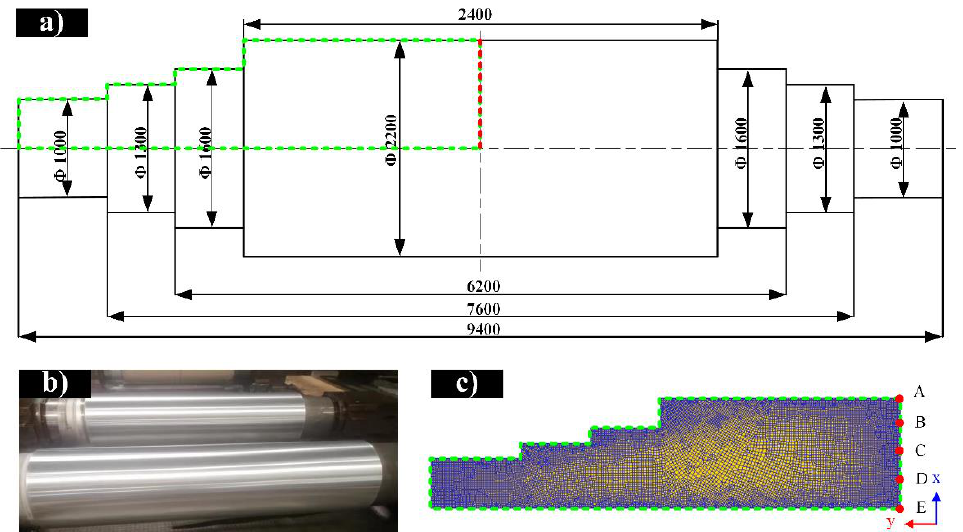
Figure 2. Geometric dimension and finite element model of heavy forging. ( a ) Geometric features and dimensions of forgings; ( b ) physical drawing of heavy forgings; ( c ) grid division diagram of forging DEFORM ® model.